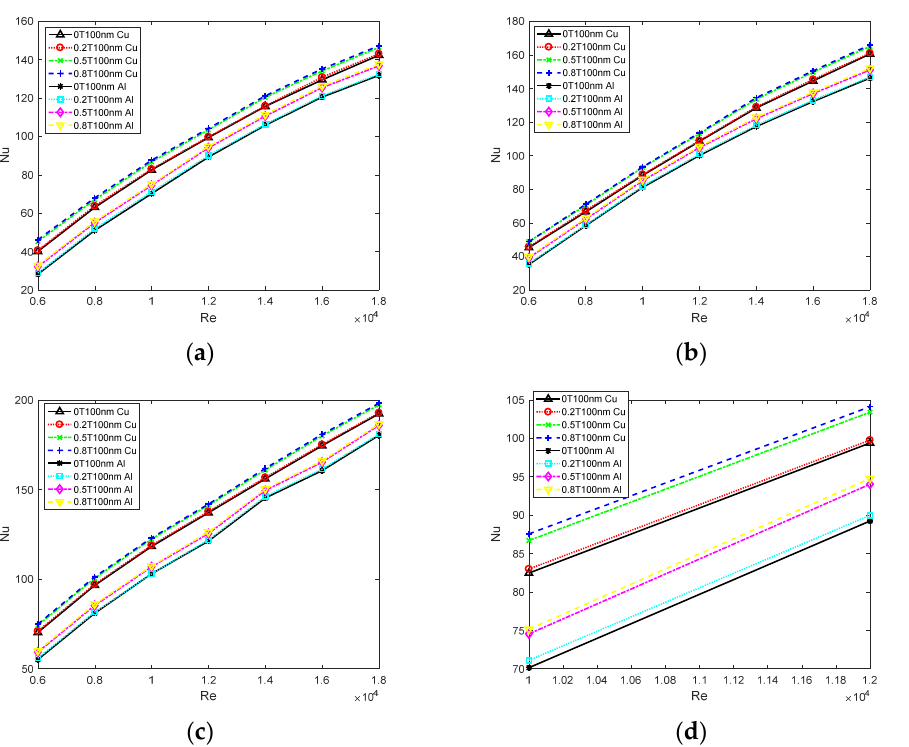
Figure 8. The Nusselt numbers of the Cu-H 2 O and Al-H 2 O nanofluids flow varied with different Reynolds numbers. The magnetic fields were applied along the Z direction and the intensities of magnetic fields were 0.2 T, 0.5 T, and 0.8 T. The volume fractions of nanoparticles were 0.5% ( a ), 1% ( b ), and 2% ( c ). ( d ) Zoom in ( a ) for details concerning when Re was 10,000 and 12,000.